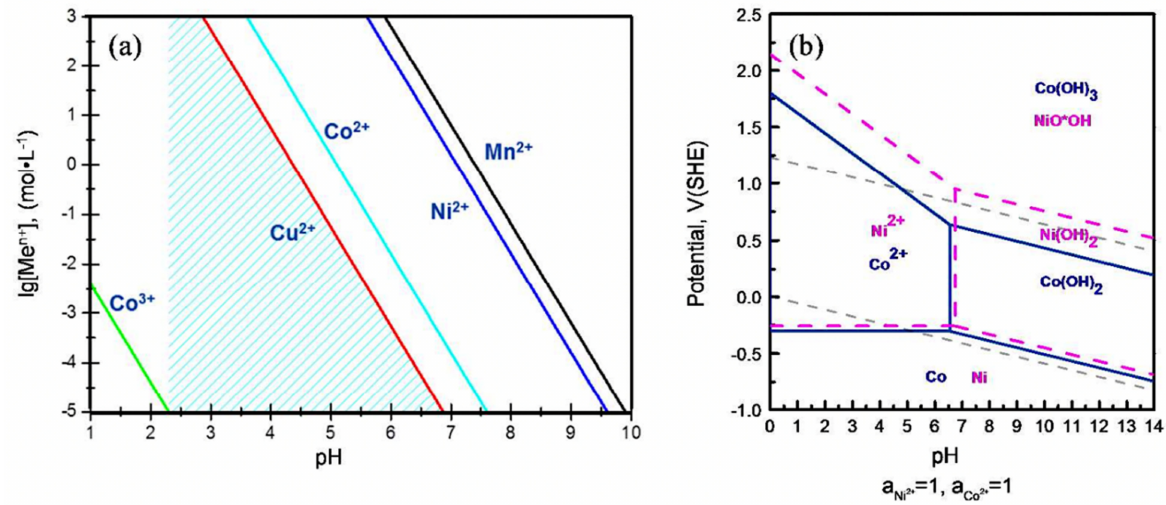
Figure 11. ( a ) Correlation between equilibrium aqueous metal ion concentration (at 25 ◦ C) and pH; ( b ) Potential (E vs. SHE) and pH diagram for the Ni-H 2 O and Co-H 2 O systems (at 25 ◦ C, Co = Ni = 0.2 mol L –1 ) (Figure adapted from ref.